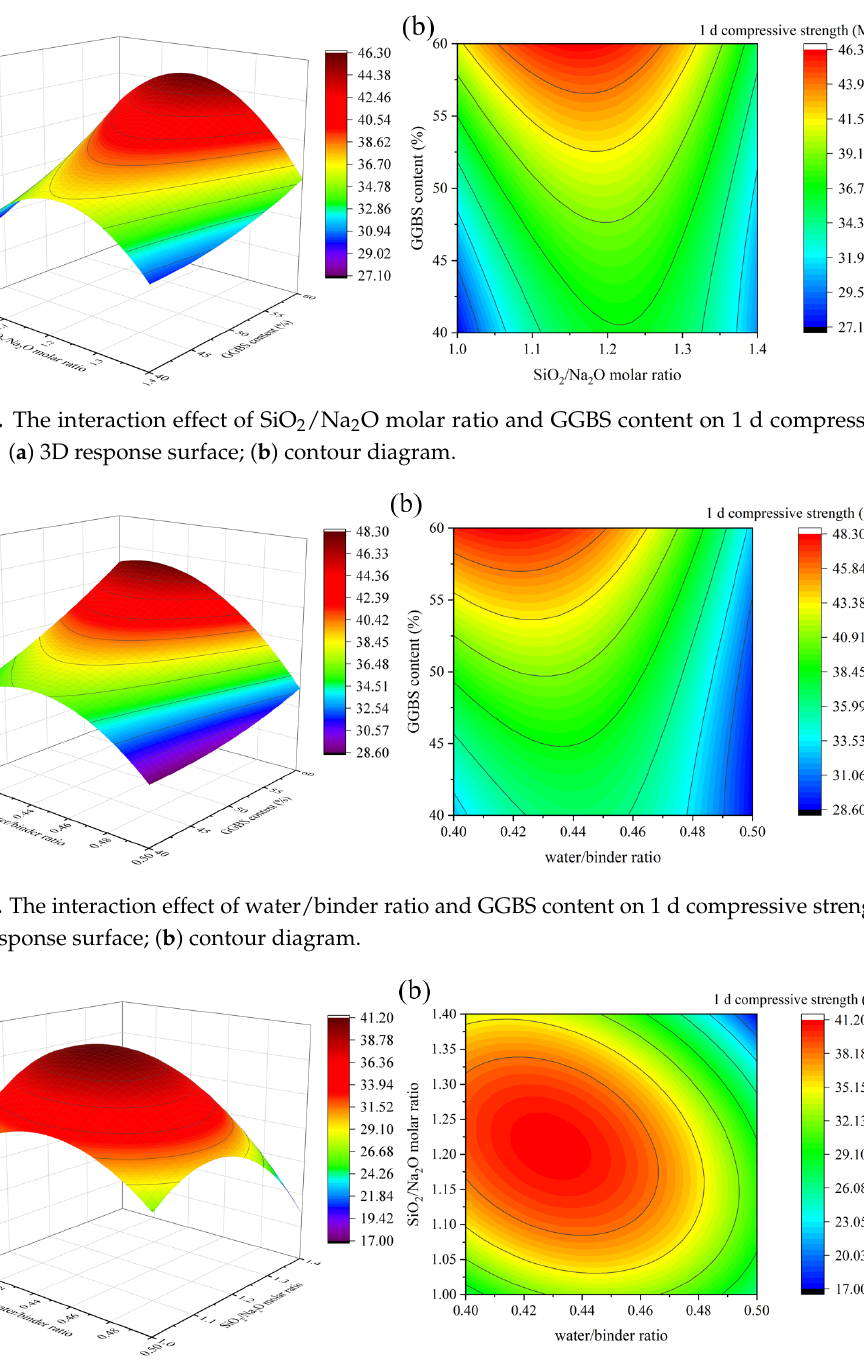
Figure 8. The interaction effect of water/binder ratio and SiO 2 /Na 2 O molar ratio on 1d compressive strength: ( a ) 3D response surface; ( b ) contour diagram.